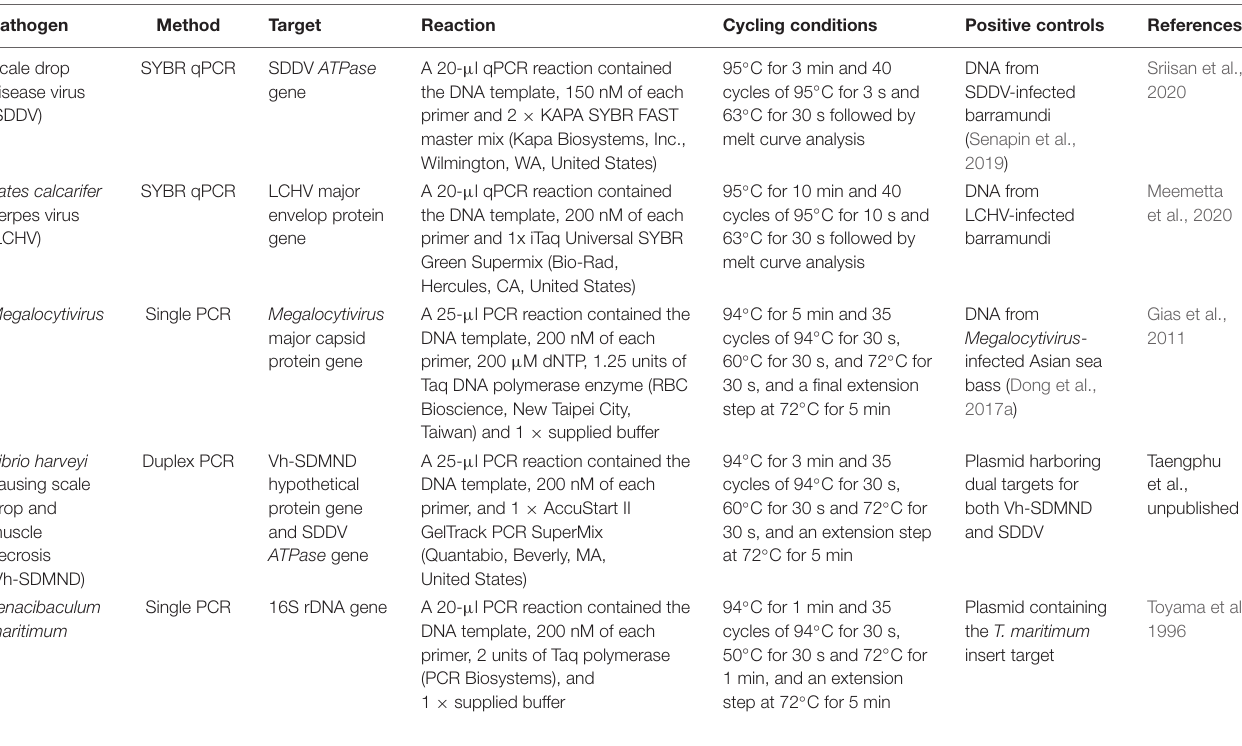
TABLE 1 | Summary of molecular tests employed to detect and/or quantify pathogens present in kidney and liver of barramundi.